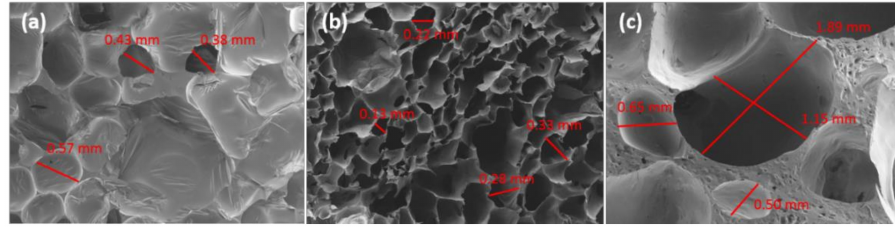
Figure 4. SEM images of ( a ) 80:20T, ( b ) 60:40T, and ( c ) 50:50T